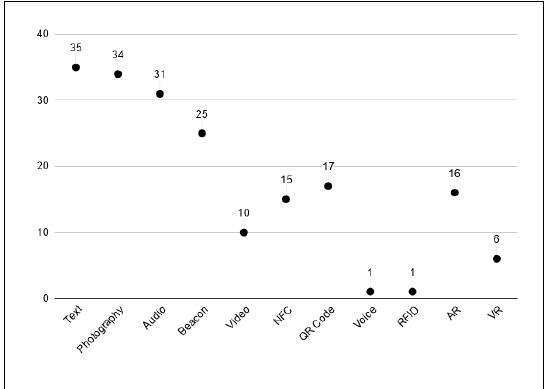
Figure 2. Application of Technologies for the Personal Mobile Guides in 36 museums of Korea.